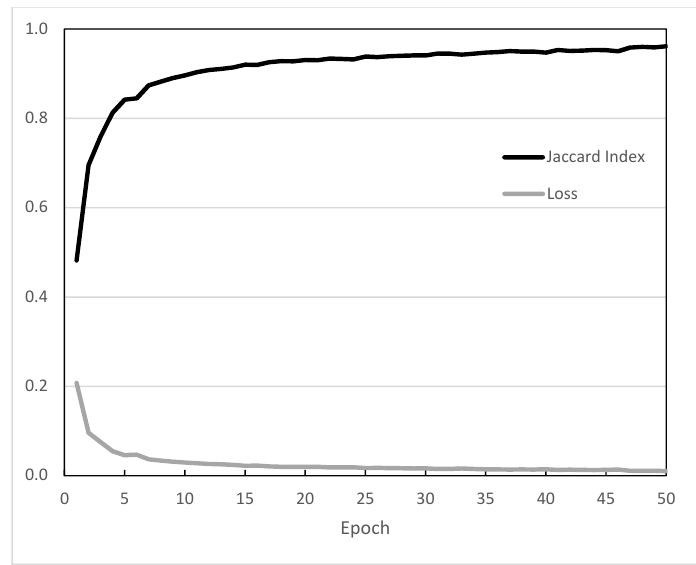
Figure 5. The Jaccard Index and loss function for each epoch. The number of epochs was restricted to 50. A marginal improvement may have been recorded if allowed to continue.